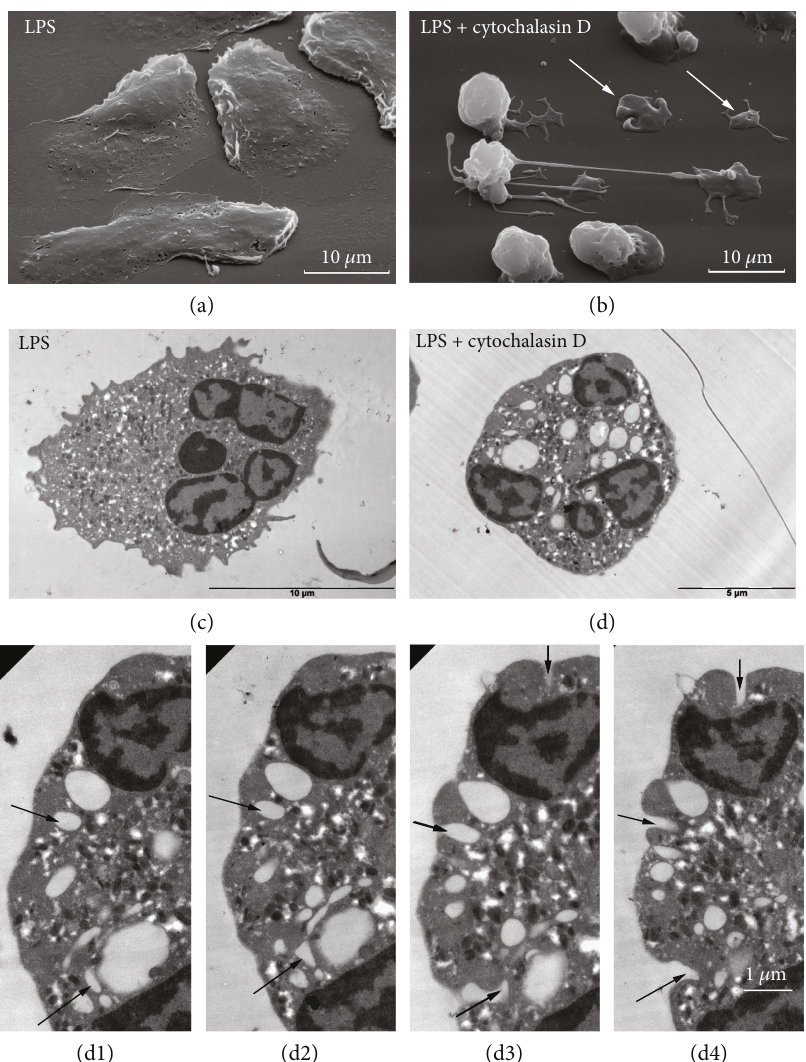
Figure 2: E ff ect of cytochalasin D on the external and internal morphology of LPS-treated neutrophils upon adhesion to fi bronectin. SEM (a, b) and TEM (c, d) images of neutrophils that were attached to fi bronectin-coated substrata over a period of 20min in the presence of 20 μ M LPS, taken alone (a, c) or together with 10 μ M cytochalasin D (b, d) and TEM images of the thin seral sections of the cell that was attached to substrata in the presence of 20 μ M LPS together with 10 μ M cytochalasin D (d1 – d4). White arrows indicate cytoplasm islands. Black arrows indicate the common exits to the exterior of intracellular vacuoles. Pictures represent typical images observed in two independent